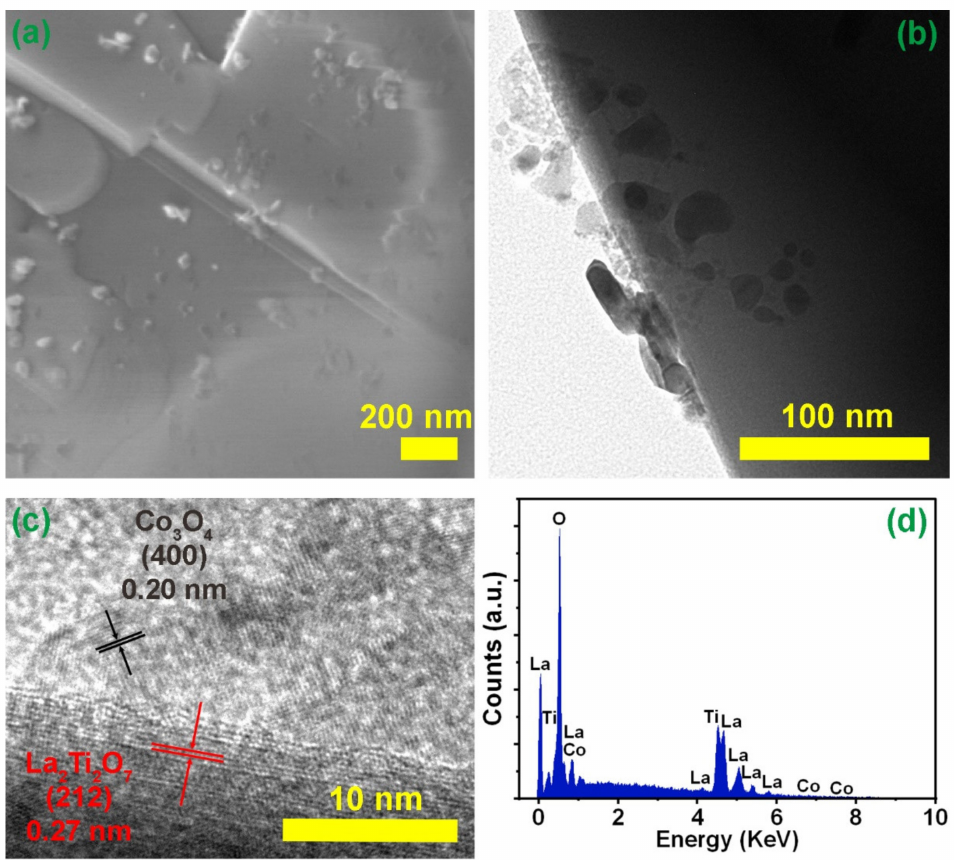
Figure 3. ( a ) High-resolution SEM image of LC3; ( b ) TEM image of LC3; ( c ) HR-TEM image of LC3; ( d ) EDS spectrum of